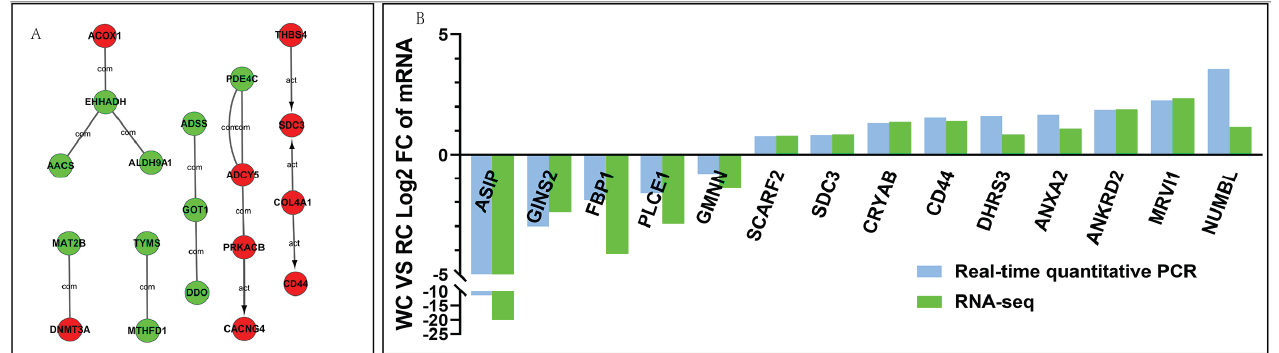
Figure 2. Prediction analysis of genes interaction network and validation of sequencing data. ( A ) Gene interaction network: red circles represent up-regulated genes, green circles represent down-regulated genes; ( B ) the fold change of DEG expression levels.